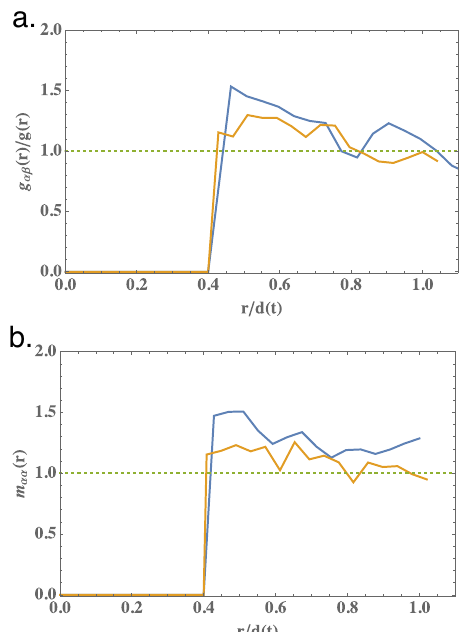
Fig. 4 The triple-junction disorientation distribution function for as deposited and annealed fi lms. a The probability density function, p ( ϕ ), for triple-junction disorientation, ϕ , for as deposited Al fi lms (histogram). Also shown is the theoretical probability density function for randomly oriented grains in a cubic system (blue line), as determined by MacKenzie 23 . Note the texturing that is evident for ϕ ≈ 60 o , corresponding to a twin. b The same as for part a ., except for the annealed fi lm.